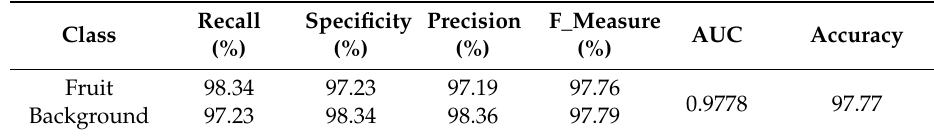
Table 9. The performance of the hybrid ANN-FA classifier based on di ff erent criteria in the best state of training for the testing data.